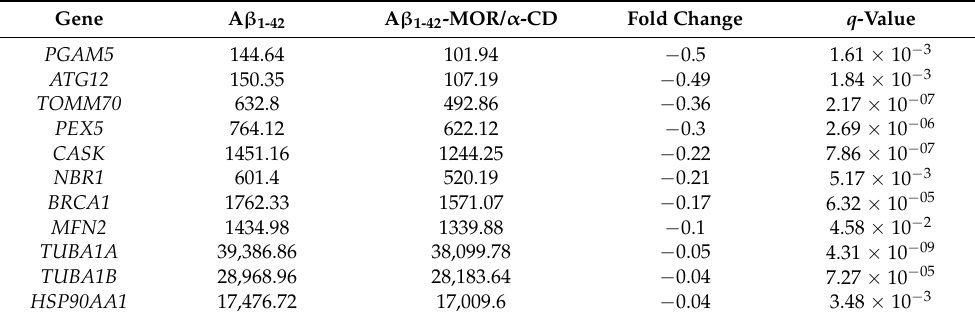
Table 4. Differentially expressed genes exclusively enriched in “Autophagy” group.